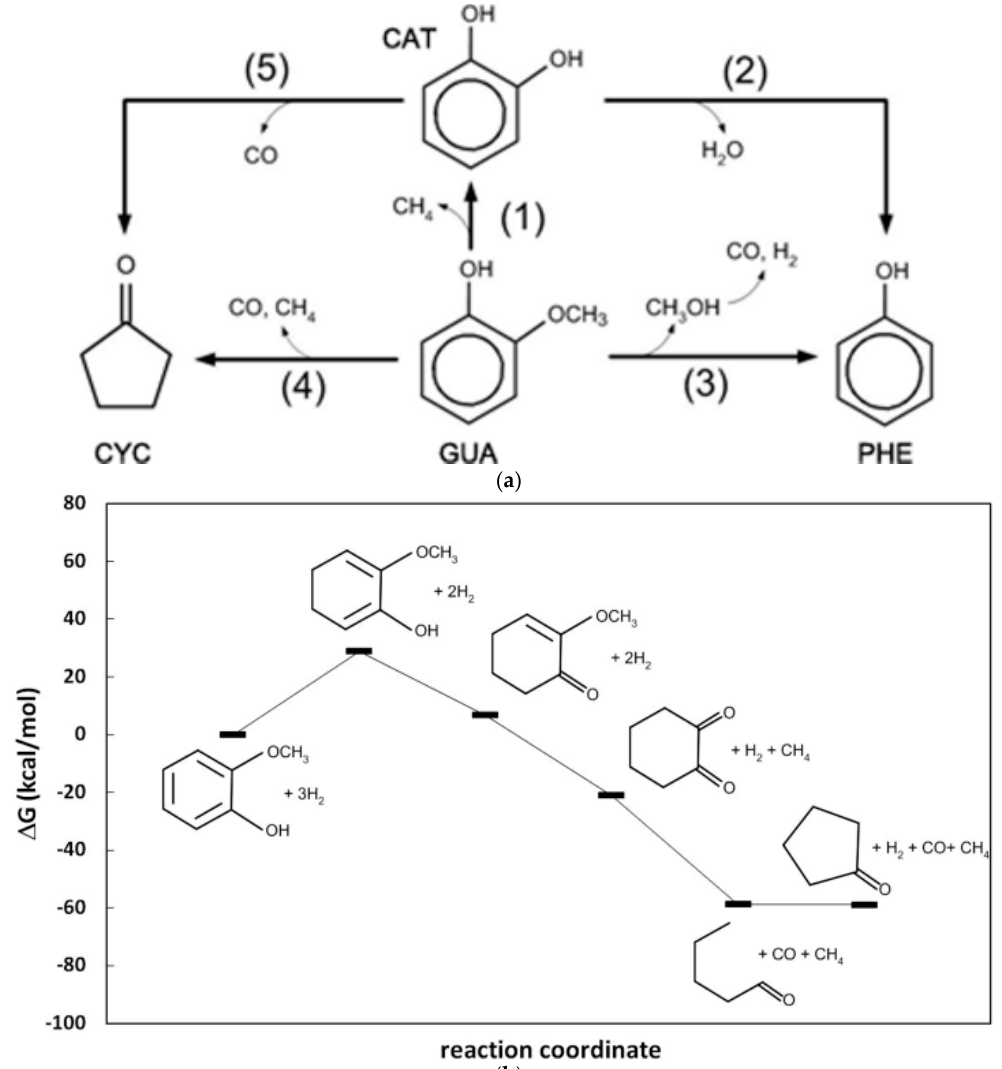
Figure 13. ( a ) Reaction scheme for HDO of guaiacol over Pt/C catalyst in the temperature range of 275–325 ◦ C under atmospheric pressure over Pt/C and ( b ) energy levels for reaction coordinate calculated with DFT for Pt(111) surface [22].